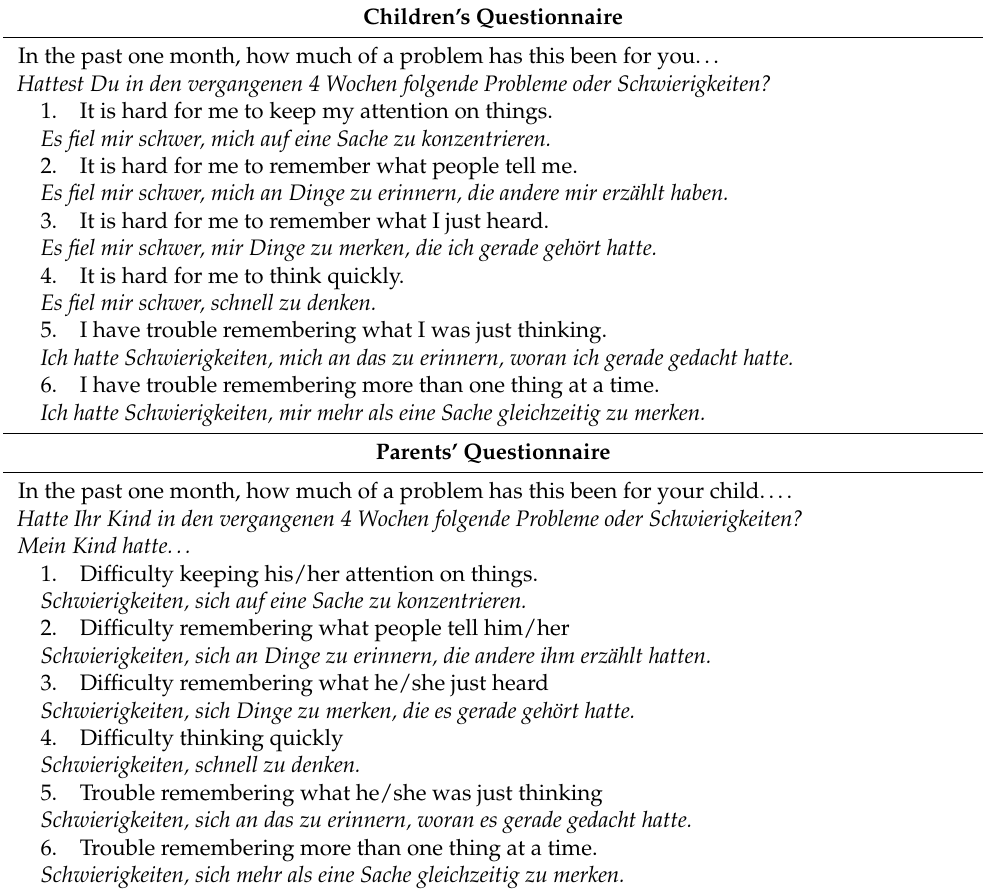
Table A1. PedsQL TM cognitive functioning module. Children’s